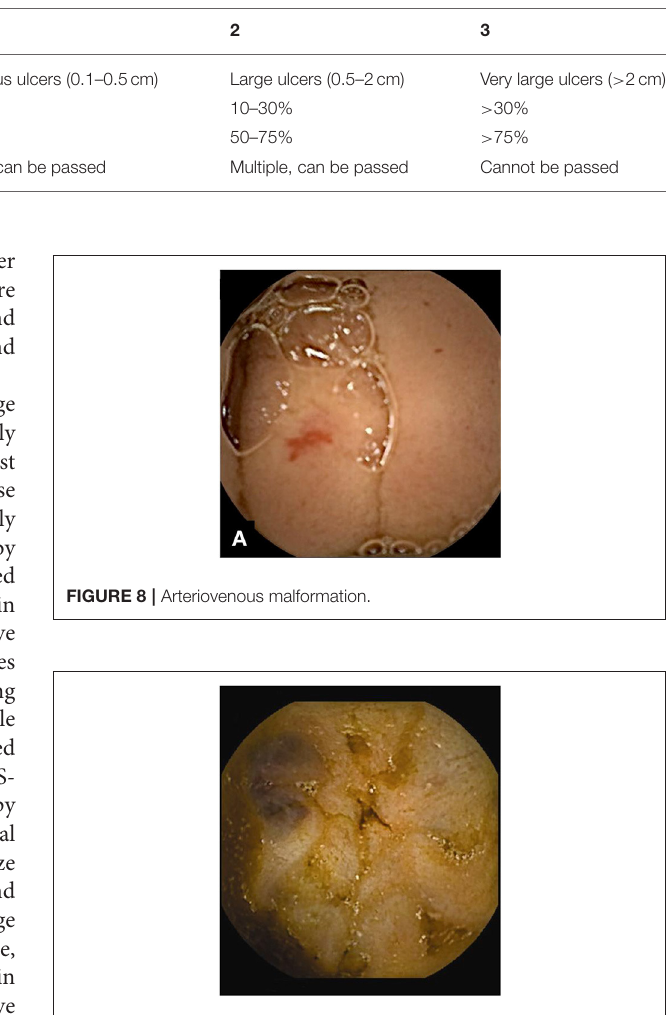
FIGURE 9 | Vascular